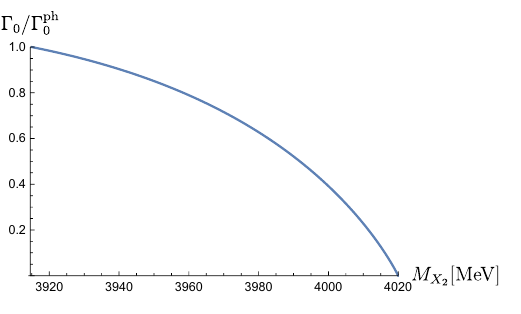
Figure 2. The helicity-0 contribution to the width, Γ 0 ( X 2 → γγ ), in units of its physical value (that is, its value at the mass 3915 MeV) as a function of the mass of the X 2 state. In this ratio, the binding energy E B is